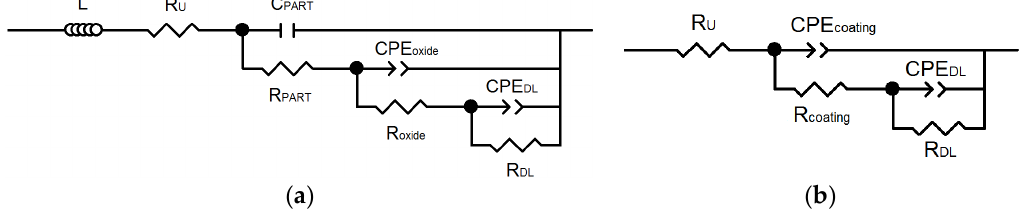
Figure 7. Equivalent circuits used for the numerical fitting of the EIS data for the uncoated ( a ) and coated ( b ) samples during immersion in a 0.1 M TBAB solution containing 5 µg·L −1 acetic acid.